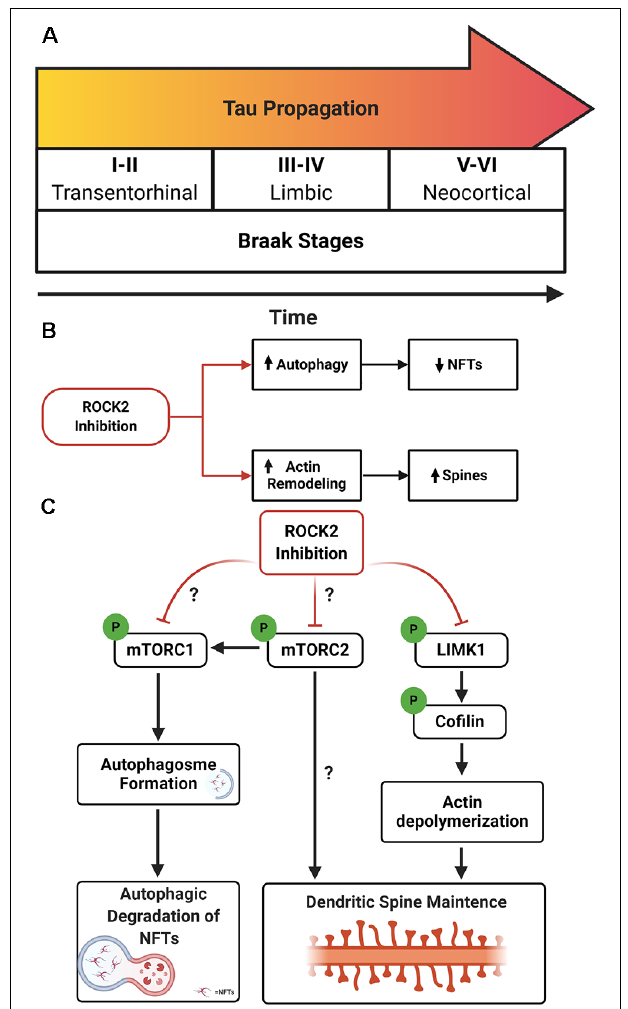
FIGURE 1 | Rho-associated coiled-coil kinase isoforms 2 (ROCK2) inhibition as a therapeutic avenue for Alzheimer’s disease (AD). (A) Schematic of Braak stages I–VI which describes the hypothetical spread of neurofibrillary tangles (NFTs) over time in AD. Tau aggregates initiate in the entorhinal cortex (EC; stages I–II) before spreading to limbic regions such as the hippocampus (stages III–IV) and eventually the neocortex (stages V–VI). (B) Therapeutic benefits of targeting ROCK2 in AD. Pharmacologic inhibition of ROCK2 enhances autophagic processes, reducing tau protein levels and pathology. In parallel, ROCK2 inhibition can increase actin dynamics, stimulating dendritic spine structural plasticity. (C) Mechanisms of ROCK2 therapeutics. (Left to right) ROCK2 inhibition reduces mammalian target of rapamycin (mTOR) phosphorylation which stimulates autophagosome formation and facilitates tau aggregate degradation. Reducing mTOR phosphorylation could influence the activity of mTORC1 and/or mTORC2. ROCK2 may alter mTORC2’s role in actin cytoskeleton rearrangement. ROCK2 inhibition reduces phosphorylation of LIMK1, inactivating LIMK1. Reduced activity of LIMK1 maintains cofilin activation and actin depolymerization, enhancing structural plasticity